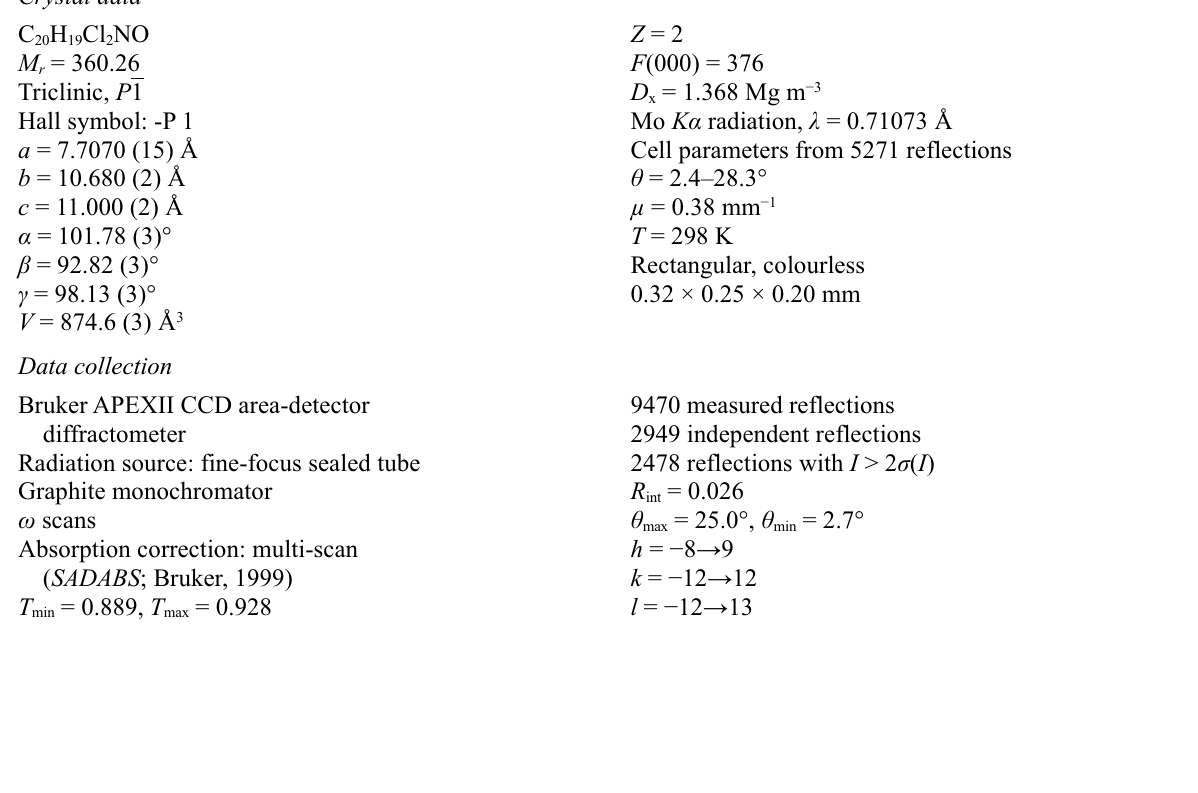
Figure 1 ORTEP view of the title molecule with atoms represented as 30% probability ellipsoids. 2,4-Bis(2-chlorophenyl)-3-azabicyclo[3.3.1]nonan-9-one Crystal